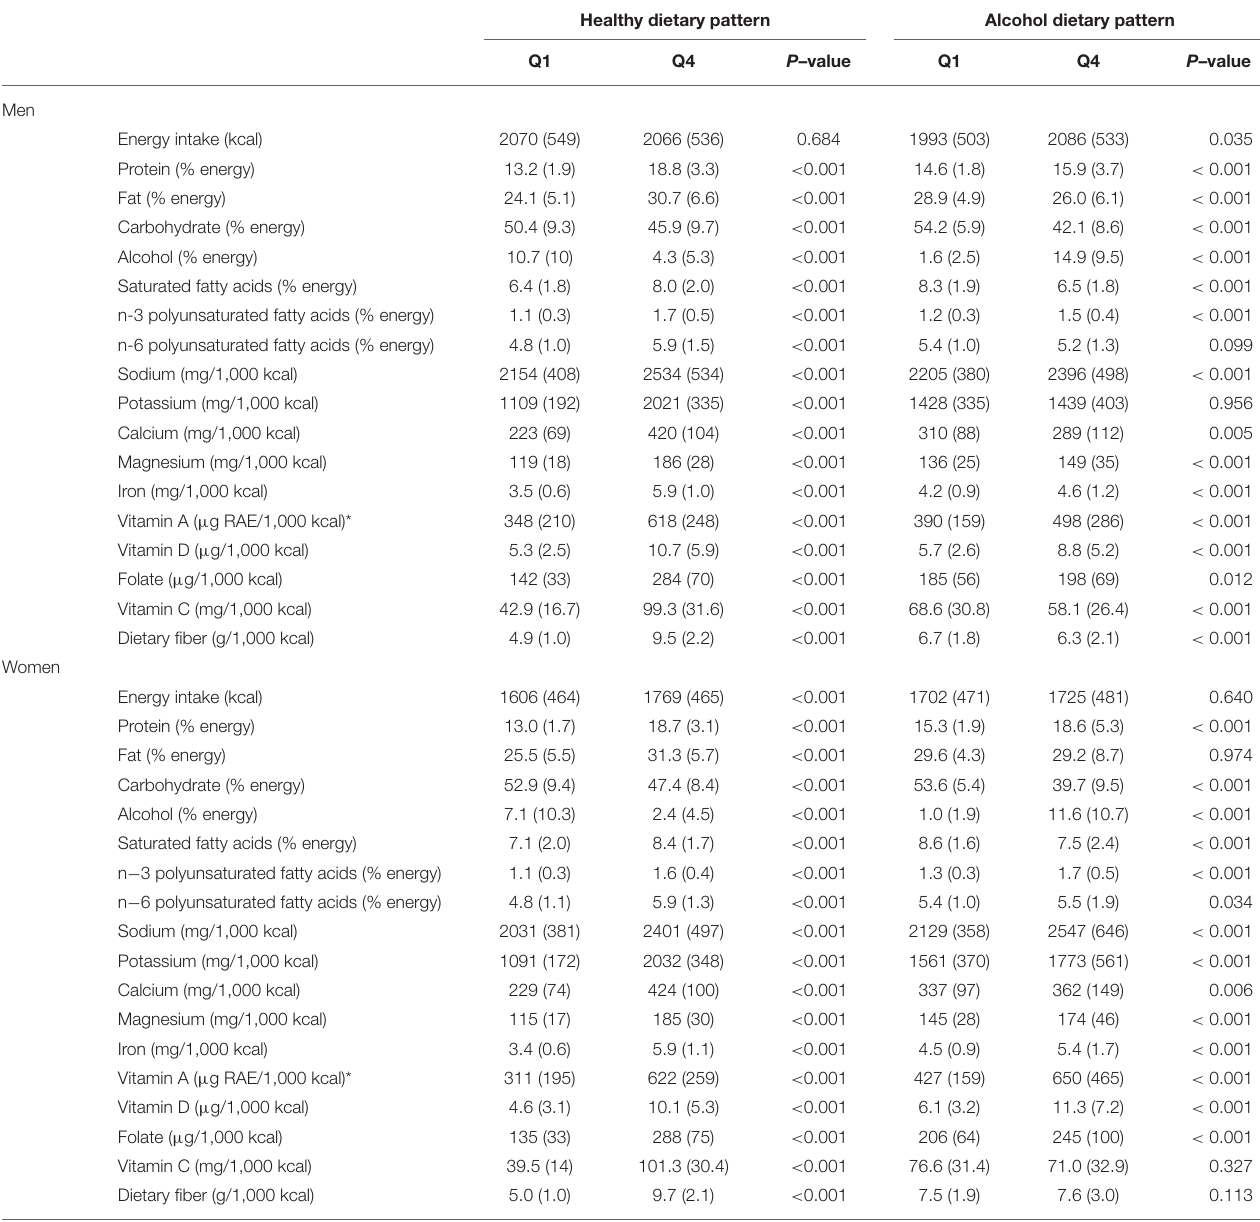
TABLE 3 | Daily nutrient intake according to dietary pattern score quartile in men vs. women. Healthy dietary pattern Alcohol dietary